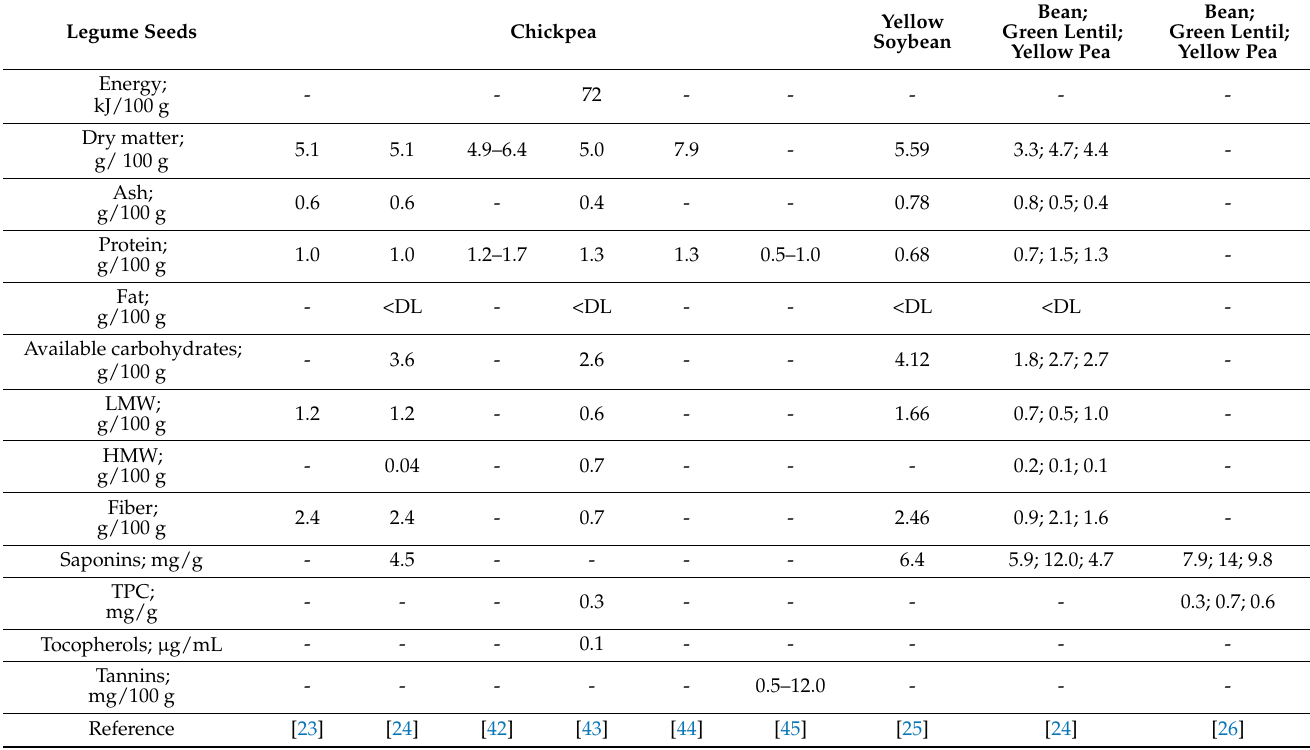
Table 2. Chemical composition of